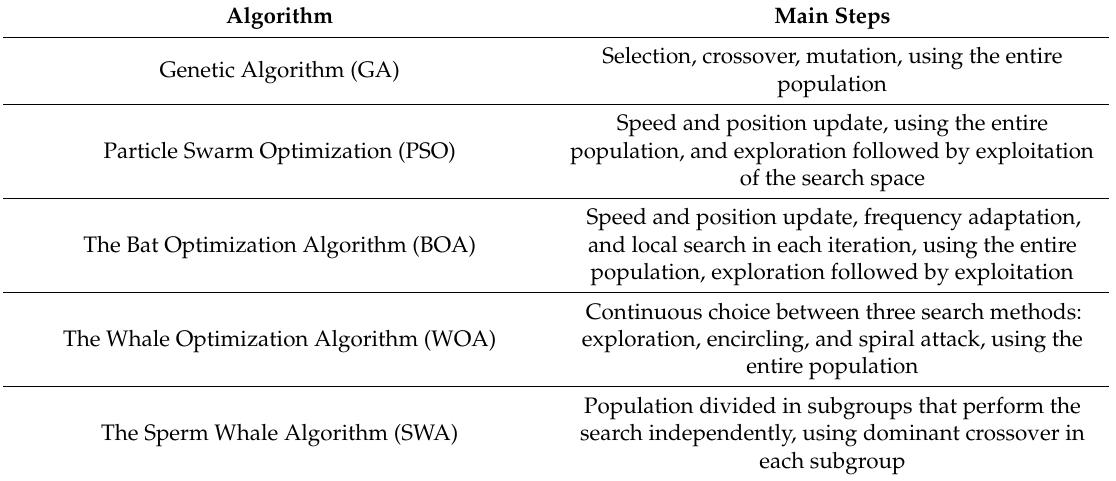
Table 2. The metaheuristic algorithms used in the paper for solving the OCBA